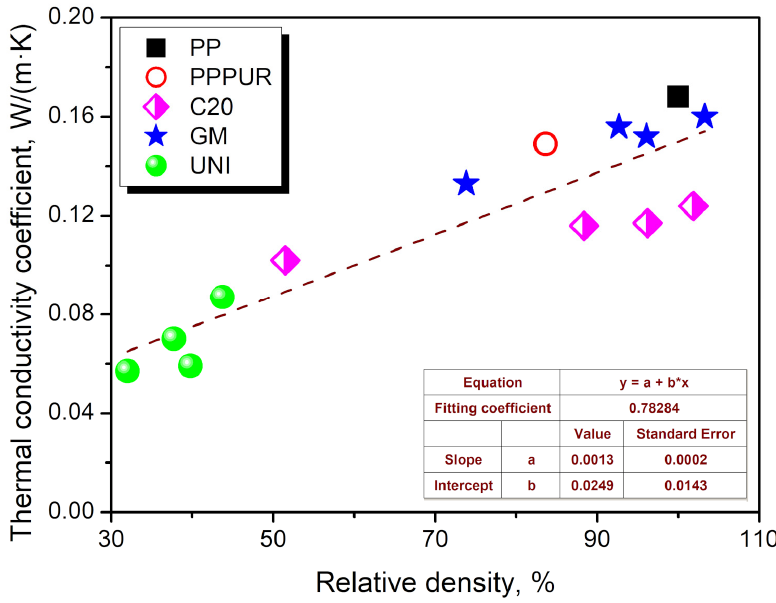
Figure 6. The relationship between λ values and relative density for the prepared samples.